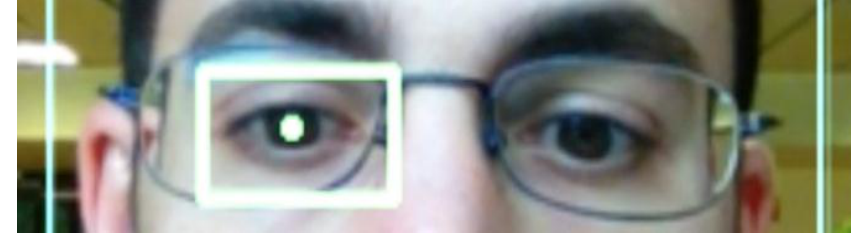
Figure 15. User with glasses 1.